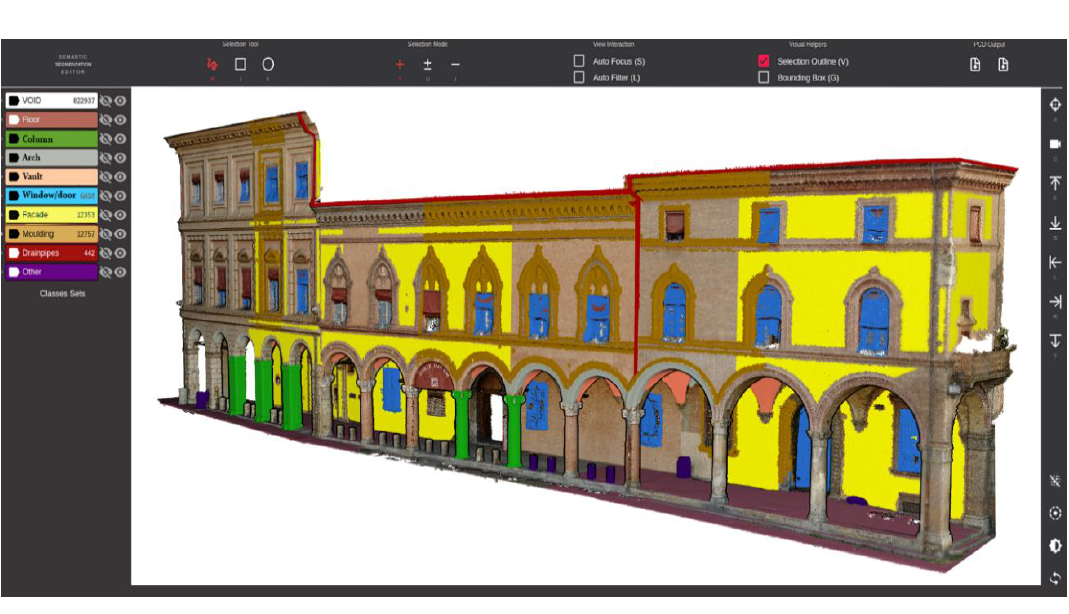
Figure 4. Our in-house web-based annotation tool.